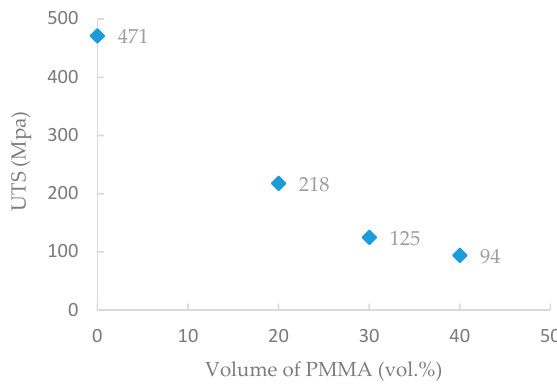
Figure 17. Tensile strength of sintered part with varied contents of polymethyl methacrylate (PMMA) space holder.